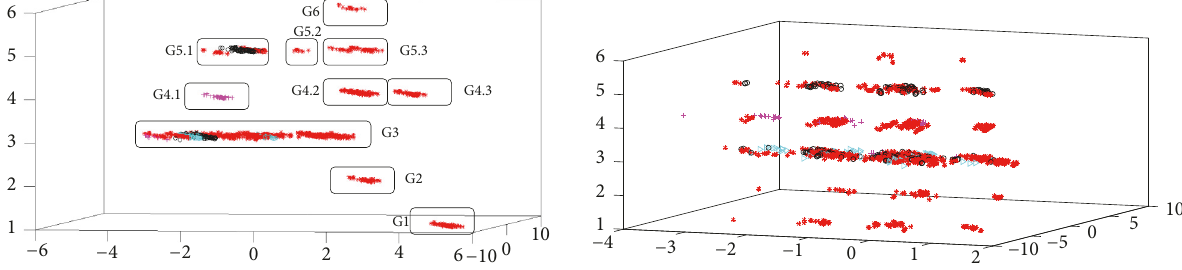
Figure 5: HUEP samples on partitional clustering ( k =6).